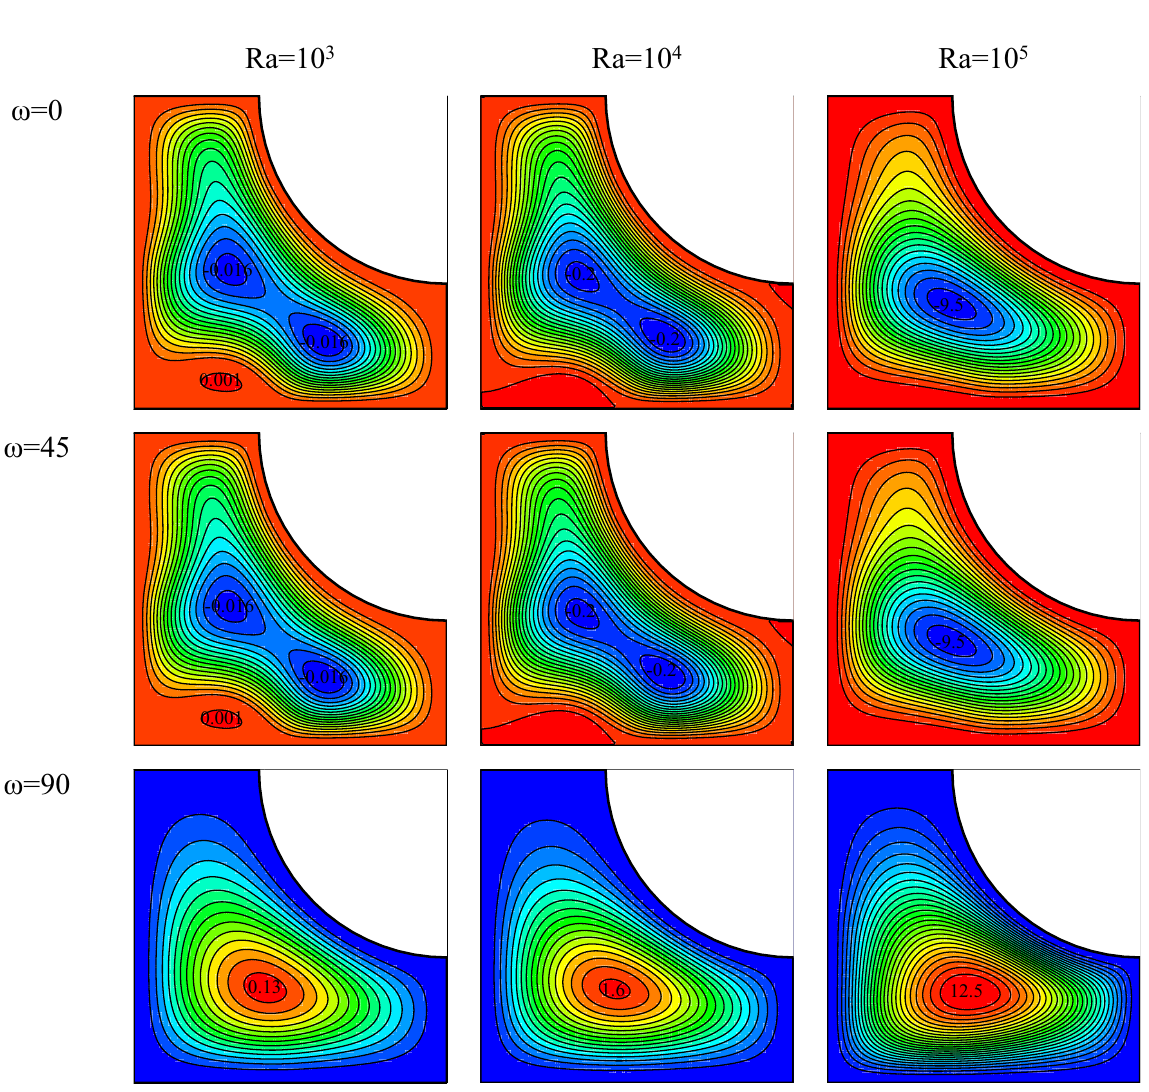
Figure 3. Flow field for Ha = 20, Rd = 1, ϕ = 0.03, γ = 45 ◦ and various Ra numbers and magnetic field